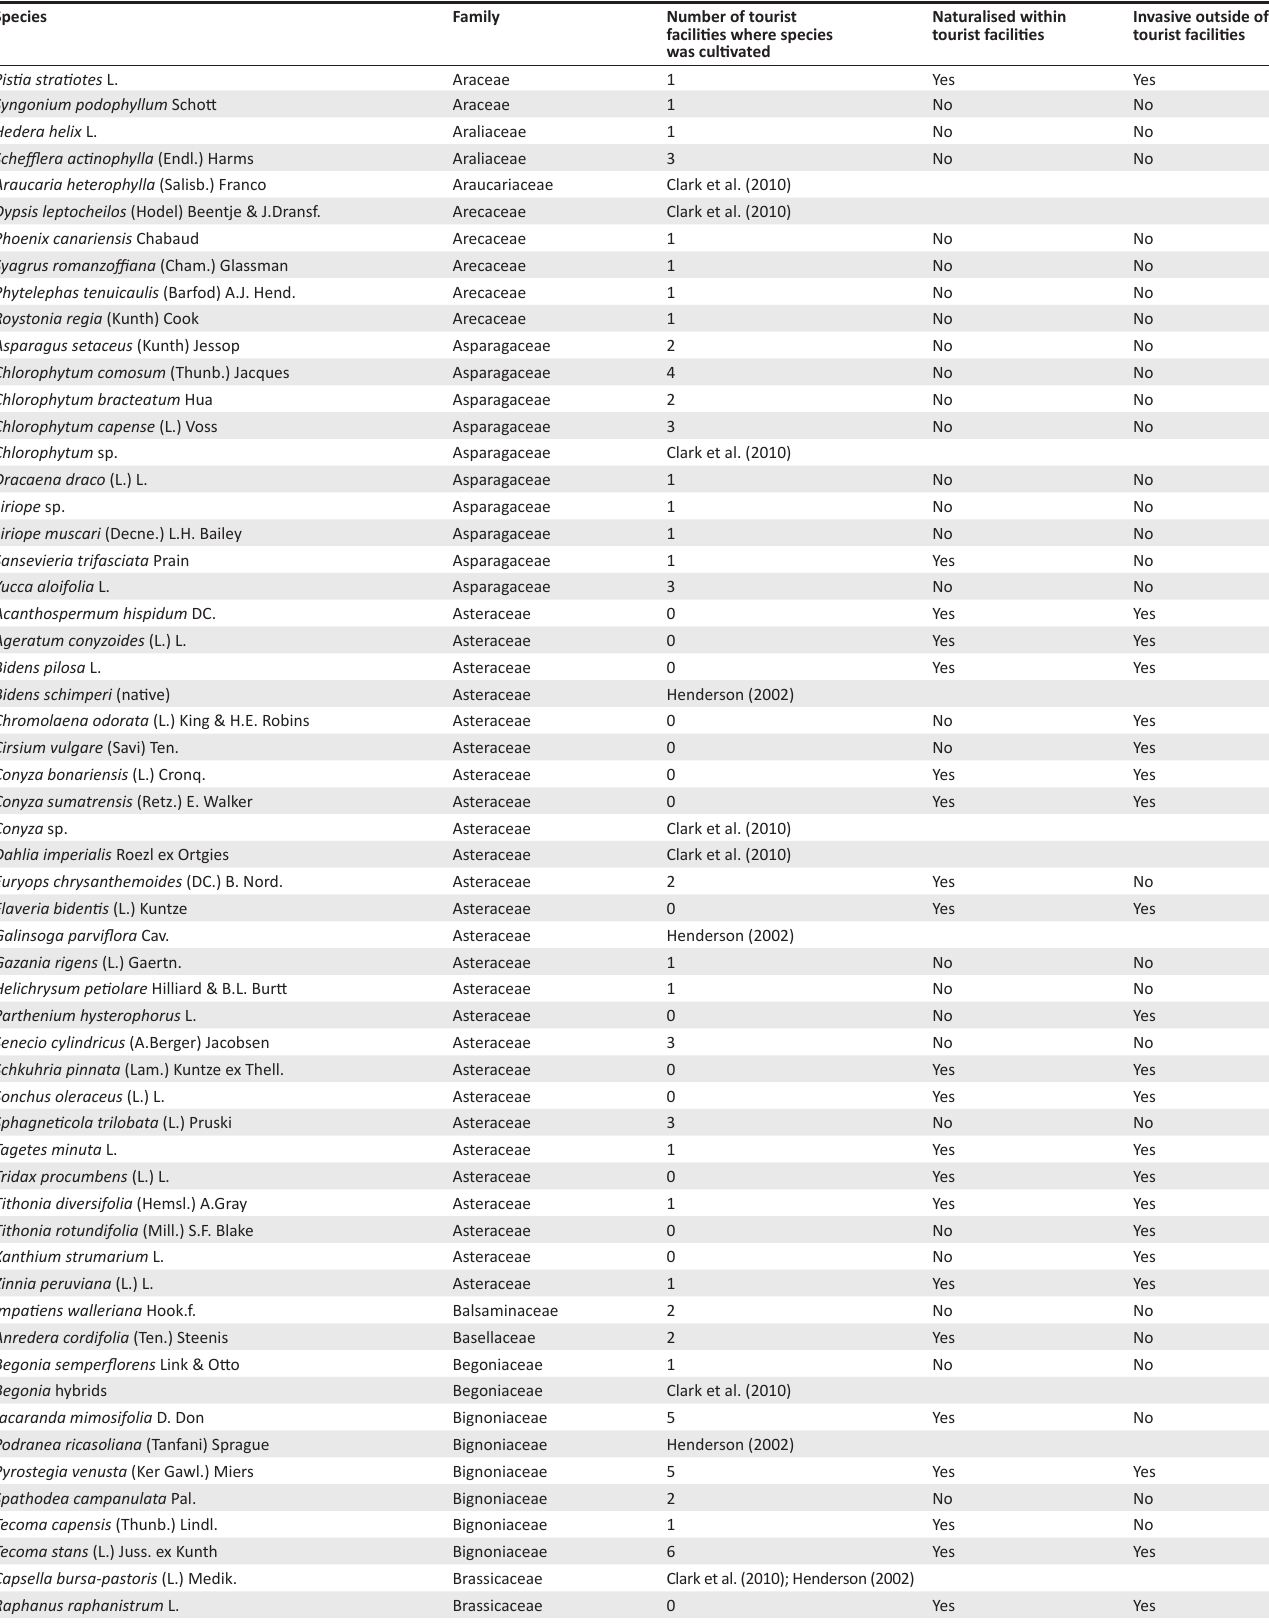
TABLE 1: (Continues...) Alien plant species, including some native plant species which may be growing outside of their natural range, recorded in the Serengeti-Mara ecosystem and immediate surrounds (excluding vegetable crops and grains).